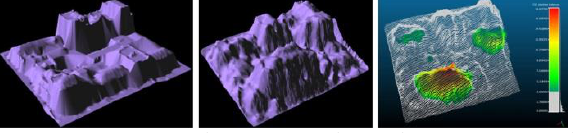
Figure 9. 3D views of the mesh surfaces of an urban block of 1983 (left) and 2010 (middle) created using manual and automatic procedures respectively; detection of significant 3D changes in the urban block (right) The building change detection results are affected by several parameters, such as the horizontal and vertical uncertainty and the roughness of the point clouds, the interpolation due to occlusions, the performance of the DIM algorithm, the method of the point cloud comparison, etc. The final products of the change detection process, can be superimposed on existing true orthoimages, DSMs, topographic vector data and GIS